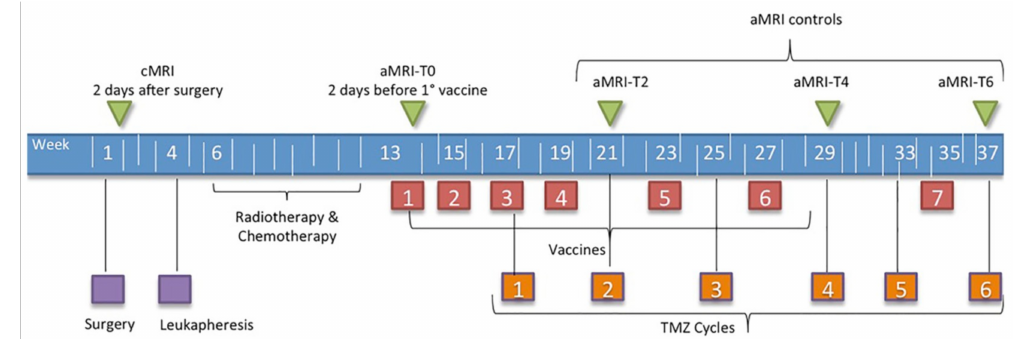
Figure 1. Schedule of treatment and follow-up time points. aMRI, Advanced magnetic resonance imaging; cMRI, conventional magnetic resonance